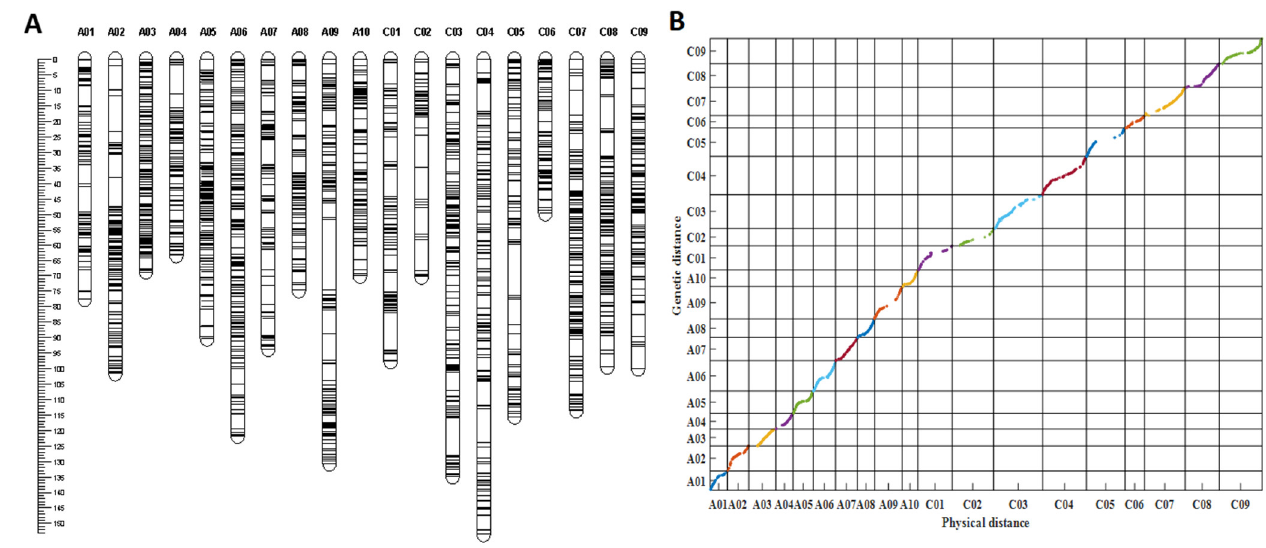
Figure 3. Information of the genetic linkage map. ( A ) The genetic linkage map with 19 linkage groups constructed by 2089 bins. ( B ) Collin-earity analysis of the genetic distances and physical distances of the markers in the linkage map; different colors represent different chromosomes or linkage groups.